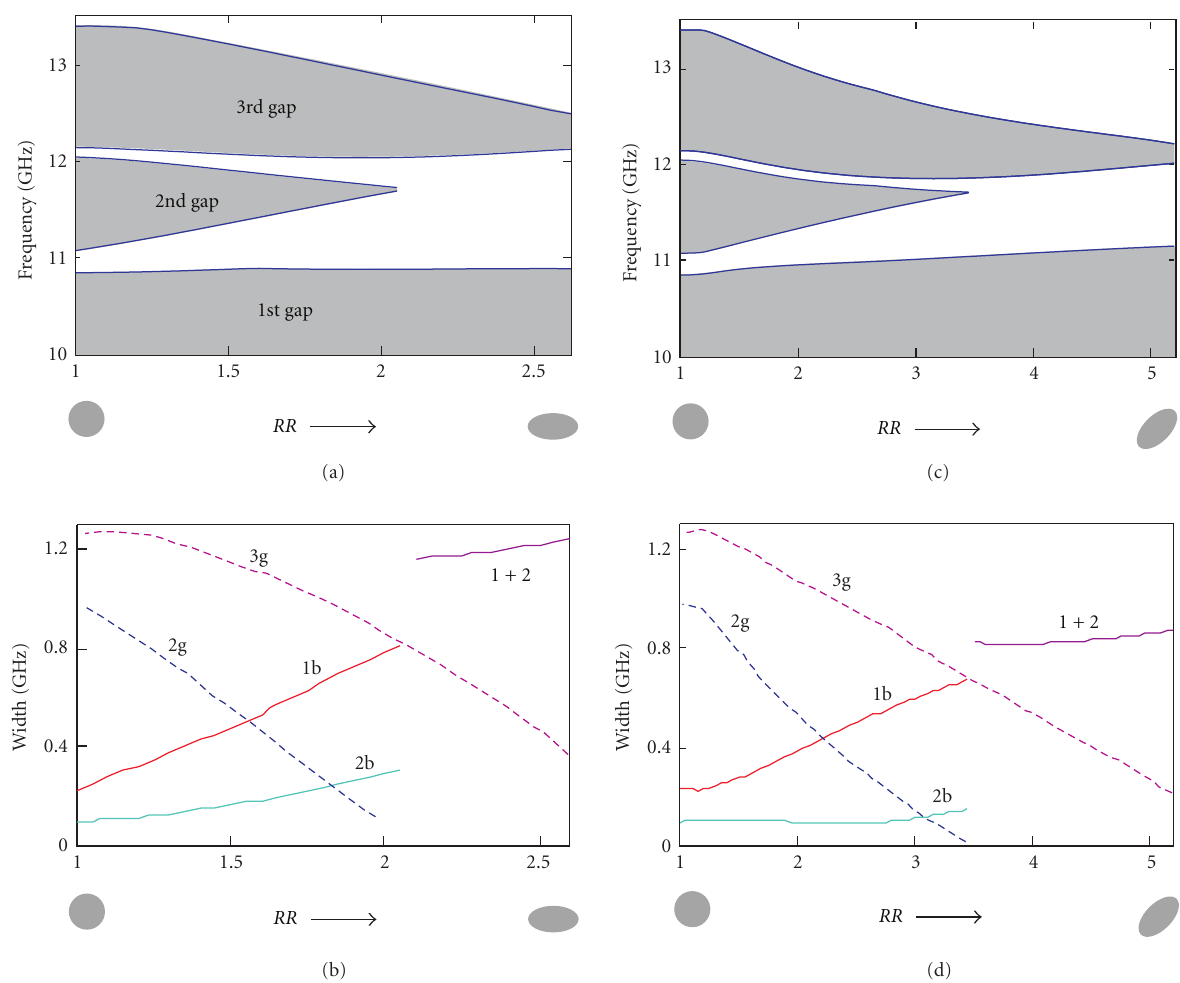
Figure 3: (a), (c) Three lowest magnonic gaps (shaded) versus rod ellipticity RR for 2D Co/Fe MCs with lattice constant 300 nm, filling fraction 0.3, and two angles of in-plane rotation of the rods: (a) α = 0 ◦ and (c) α = 45 ◦ . (b), (d) The width of the lowest gaps and bands versus RR in (a) and (c), respectively. The width of the second (2g) and third (3g) gaps is plotted with dashed line. Solid line represents the width of the lowest bands: the first (1b), the second (2b), and, in the range of RR values in which the gap between them does not occur, the band resulting from their merging (1 +